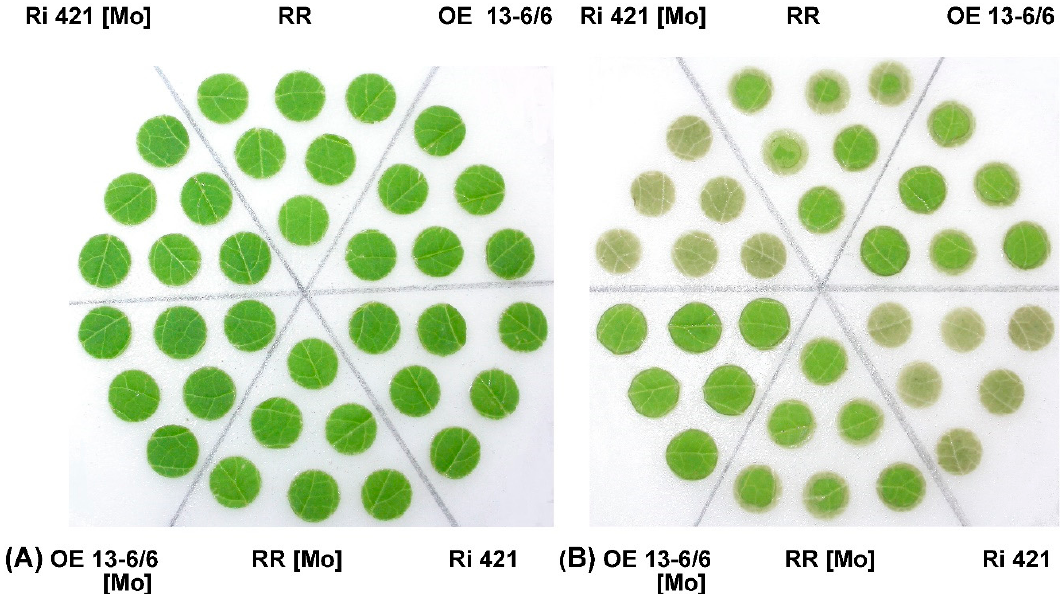
Figure 4. Response of Mo spray on the effect of sulfite treated SO modified tomato lines. Leaf discs from wild type (RR) and SO OE (OE 13-6/6) and SO Ri (Ri 421) tomato lines with (Mo) and without Mo treatment were subjected to ( A ) 0 mM and ( B ) 7 mM Na 2 SO 3 and photographed 24 h after starting the treatment.